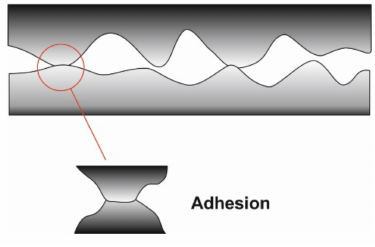
Figure 27. Schematic of adhesion model proposed by Bowden and